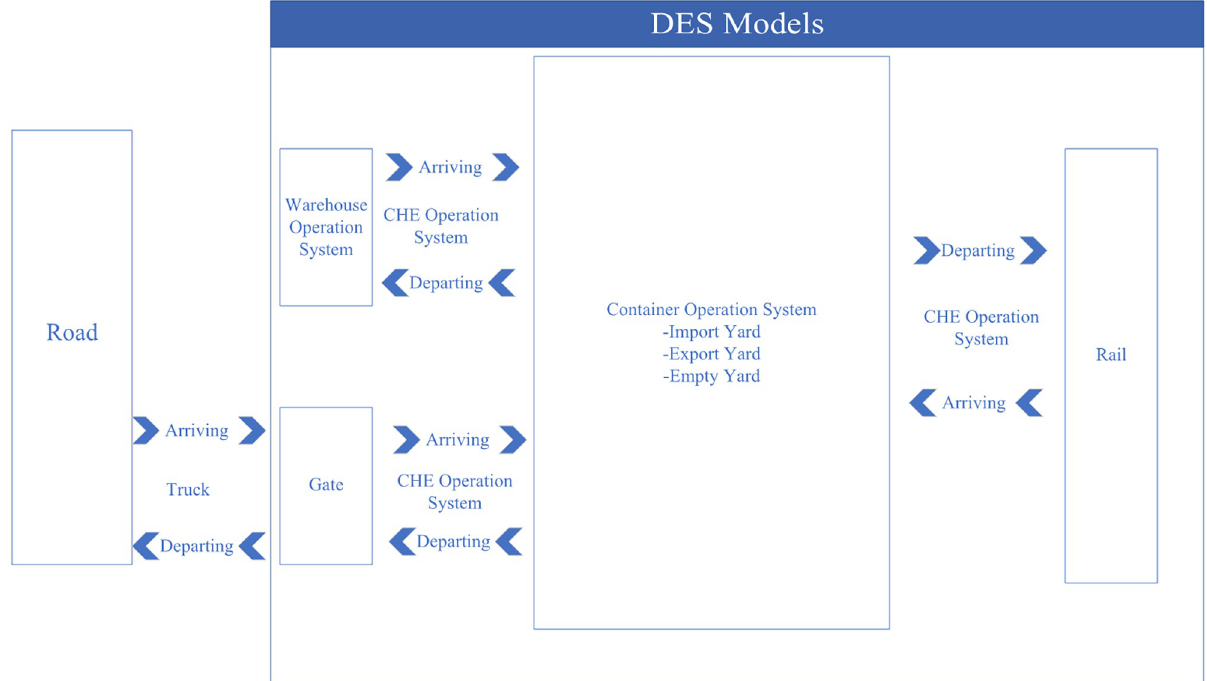
Fig 3. An overview of the proposed DES models.